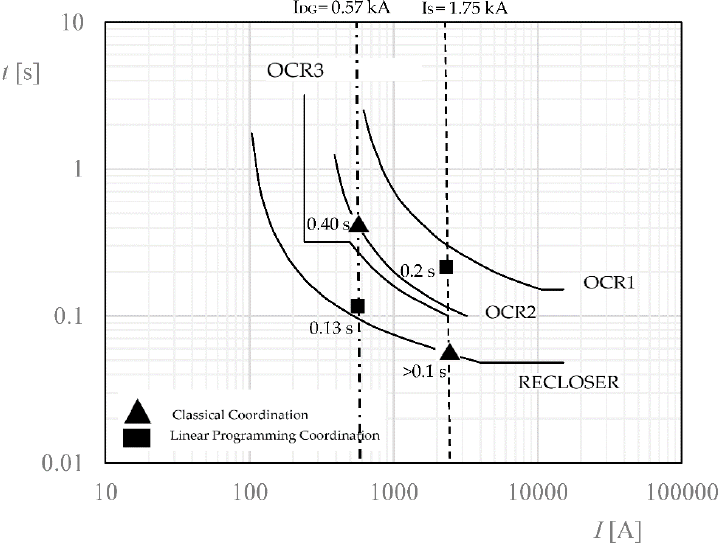
Figure 10. Short-circuit in F7 with penetration level of DG1 17%. Classical coordination versus linear programming coordination.